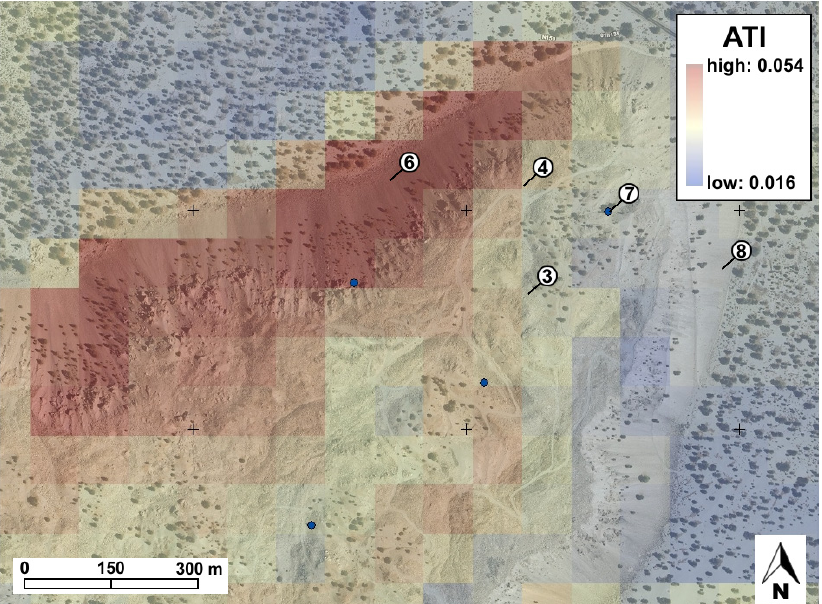
Figure 6. ATI draped over a high-resolution Digital Globe image (within Google Earth) of the northeast lobe of North Coulee. Blue dots indicate proposed field sites prior to the fieldwork being conducted. The numbered pins denote visited sites with associated field data. Note the very different ATI behavior on the northwest versus the southeast facing slopes. Figure created in ArcGIS 10 using Bing Maps layer.